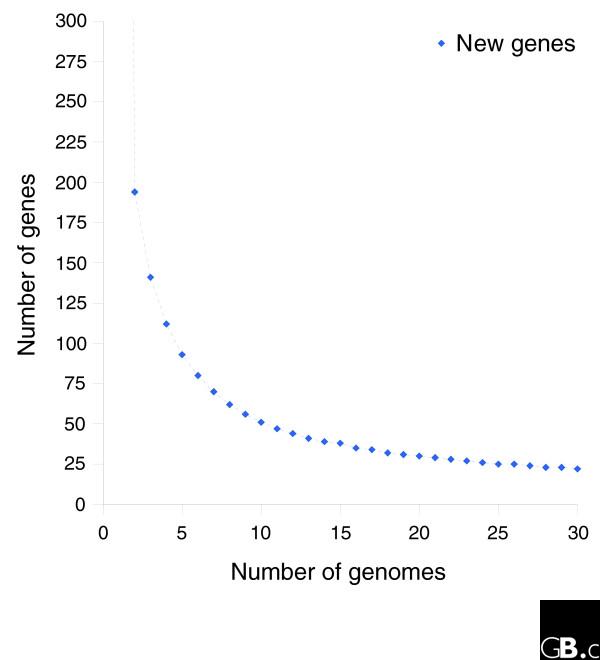
A theoretical plot of the number of new genes expected to be found in the Nth genome for future H. influenzae sequencing projects. The plot was generated using strains isolated in North America, and the extrapolation may not hold for isolates from other geographic locales if some distributed genes are geographically isolated. The model predicts that the number of new genes found in a strain will diminish 20 after sequencing 30 strains, and the number will trend toward 0 as the number of sequences becomes large.